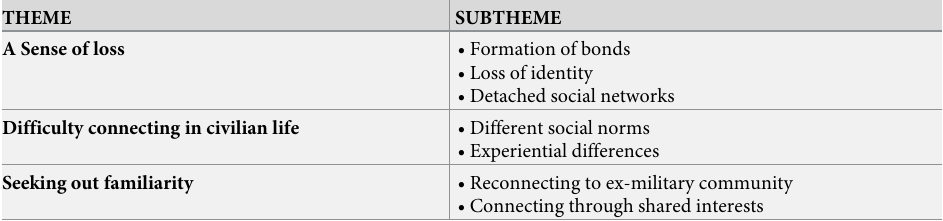
Table 2. Themes and sub-themes generated from the